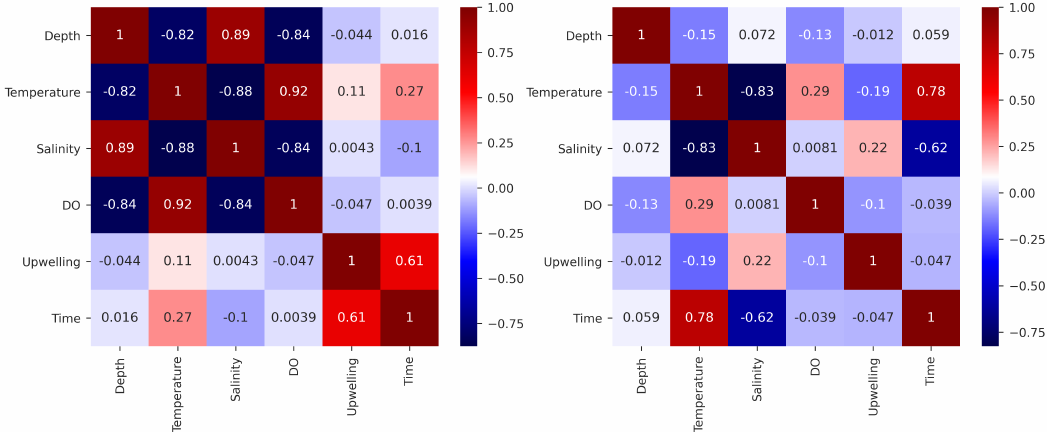
Figure 3. Correlation matrices for the offshore dataset ( left ) and nearshore dataset ( right ) for each variable combination. The Pearson correlation coefficient is given by the colorbar and it is annotated inside each grid on the